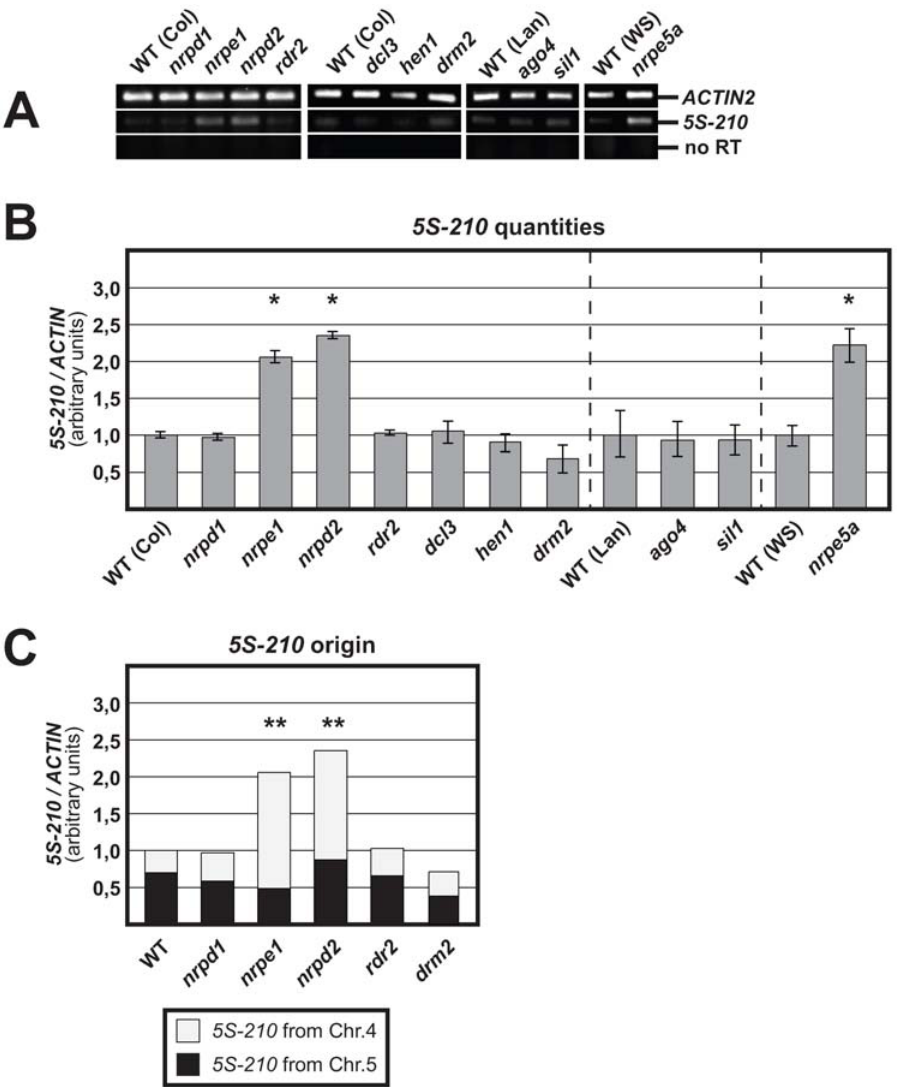
Figure 2. RT–PCR detection of 5S-210 transcripts in WT, nrpd1 , nrpe1 , nrpd2 , rdr2 , dcl3 , hen1 , drm2 , ago4 , sil1 , and nrpe5a plants. (A) Expression of ACTIN 2 was used to normalize the 5S-210 amounts. Negative controls were performed without reverse transcriptase (no RT). (B) A graphic representation of 5 to 7 independent experiments is given. The standard deviation of the mean is indicated on each bar. Asterisks indicate values significantly different from the WT value which is arbitrarily fixed as 1 (Mann-Whitney test, * P , 0.05). (C) Proportion of 5S-210 transcripts from chromosomes 4 and 5. RT-PCR products from (B) were sequenced and the T-stretch signature analysed to determine the 5S-array’ origin of 5S-210 transcripts. A total of 70, 53, 68, 51, 39, and 52 5S-210 cDNA clones were sequenced for WT, nrpd1 , nrpe1 , nrpd2 , rdr2 and drm2 respectively. Statistics were done to appreciate the participation of 5S array from chromosome 4. Asterisks denote significant differences to the WT value (Fisher’s exact test, ** P ,